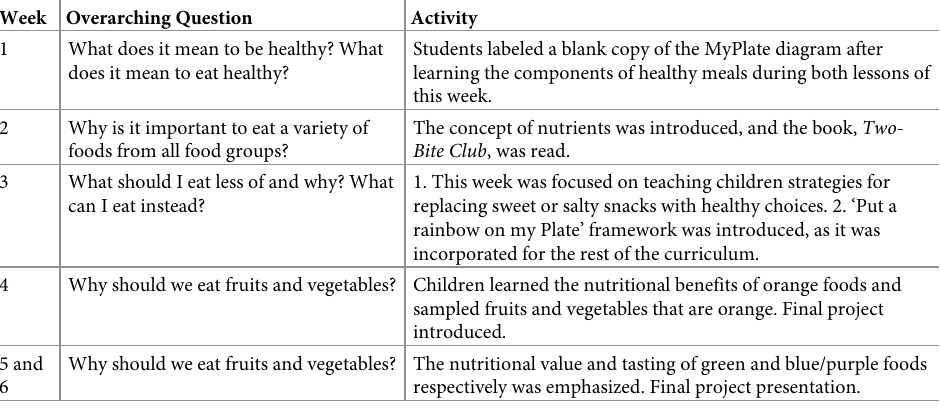
Table 1. Nutrition education curriculum